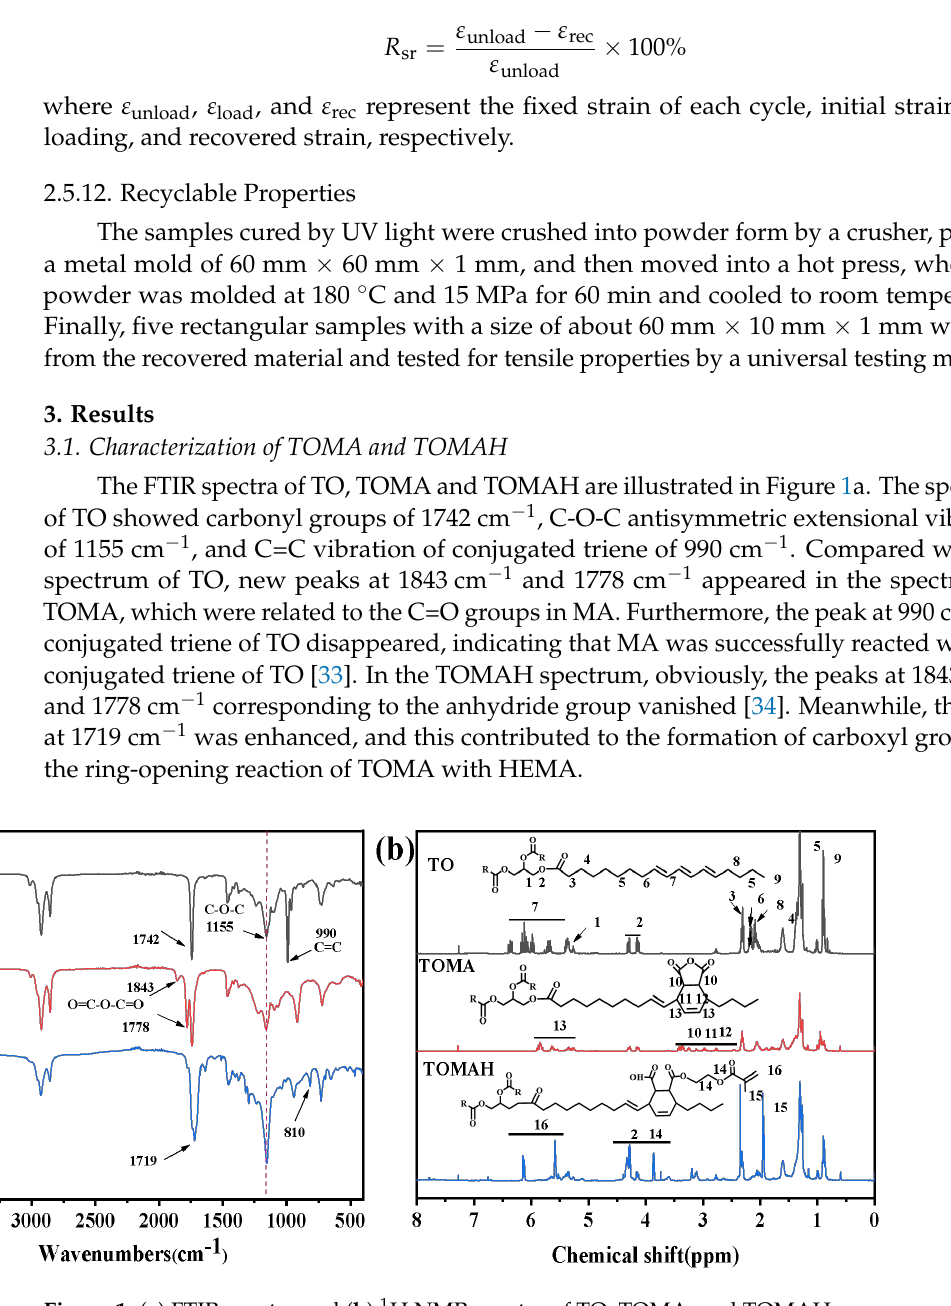
Figure 1. ( a ) FTIR spectra and ( b ) 1 H NMR spectra of TO, TOMA, and TOMAH.